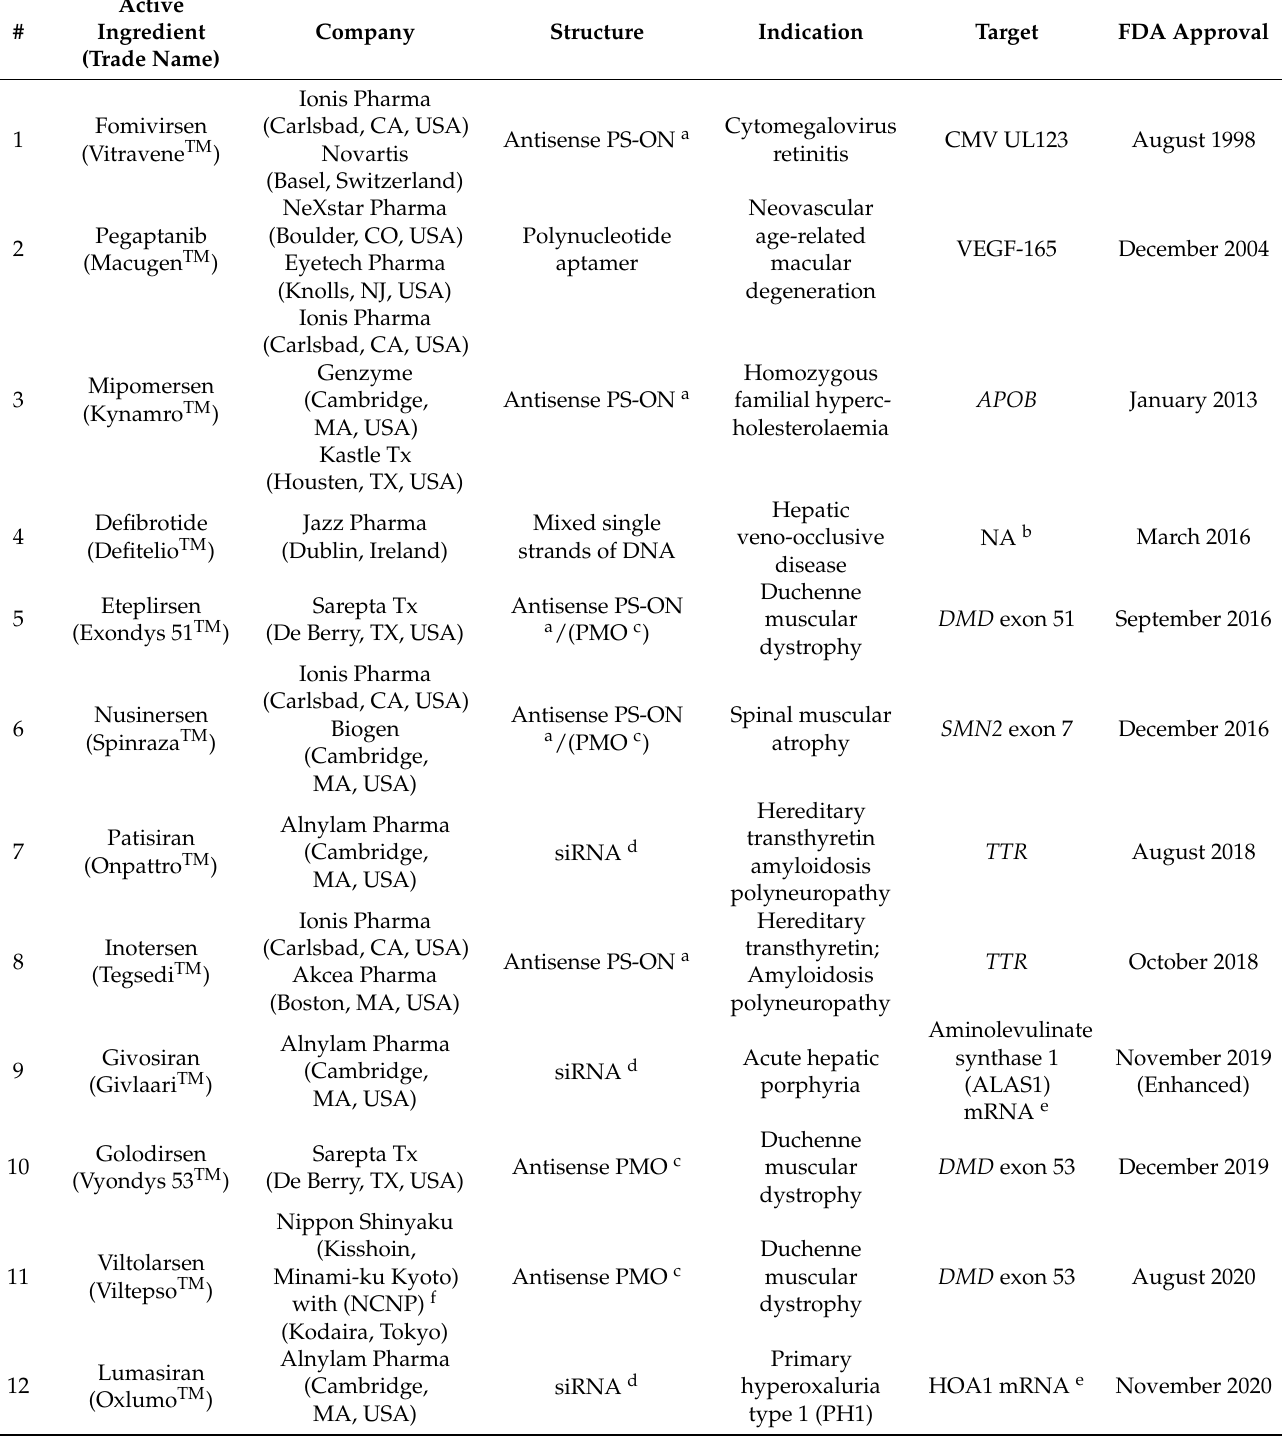
Table 2. FDA-approved oligonucleotides from